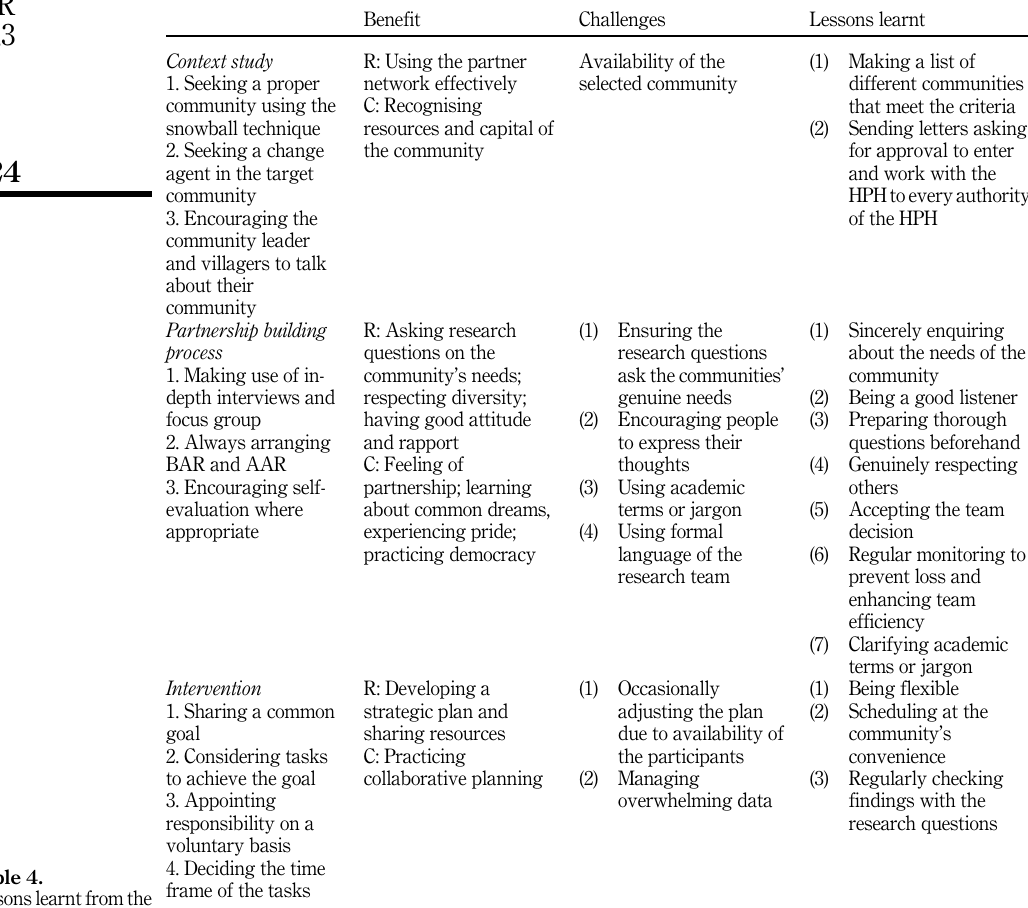
Table 4. Lessonslearntfromthe process and essential skills at Hua Don